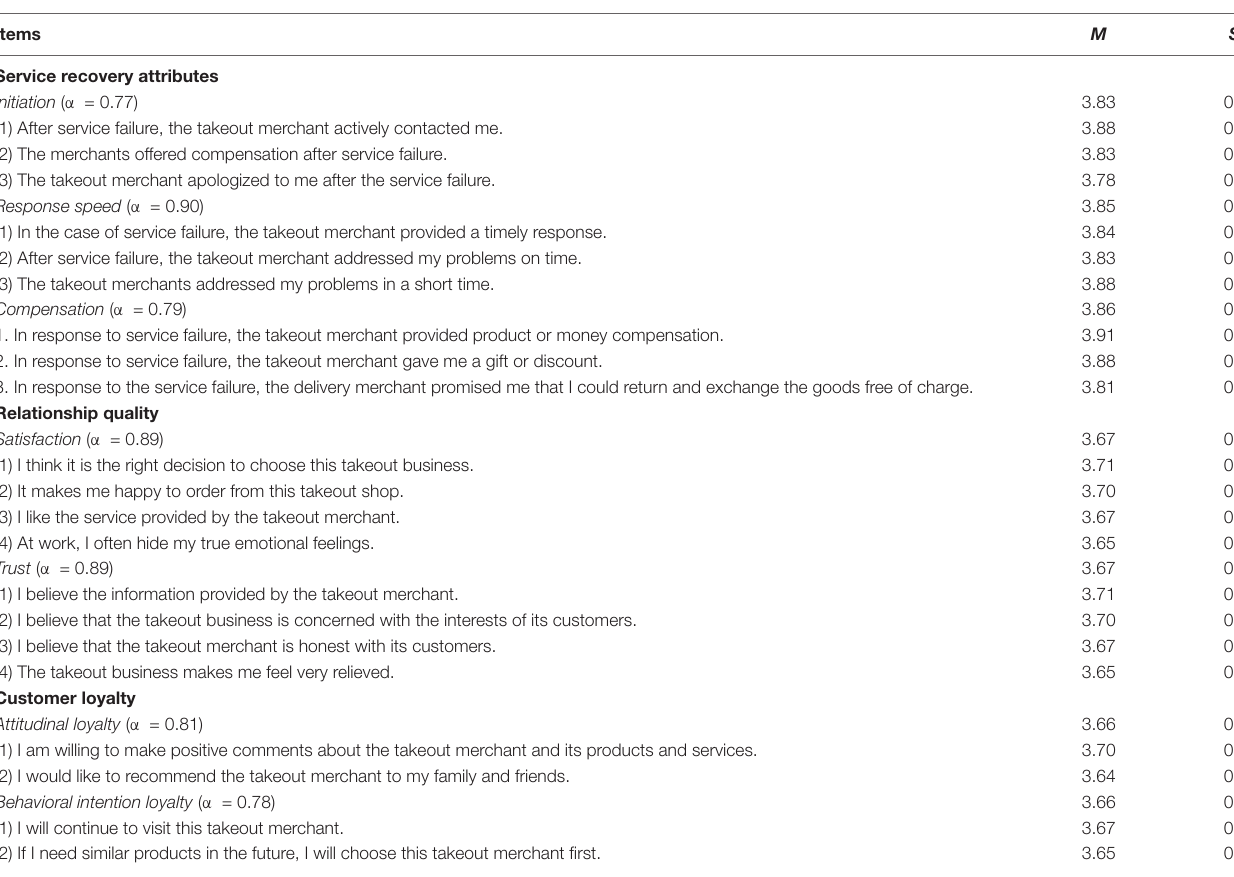
TABLE 4 | Descriptive statistics about respondents’ perceived service recovery, relationship quality and customer loyalty. Items